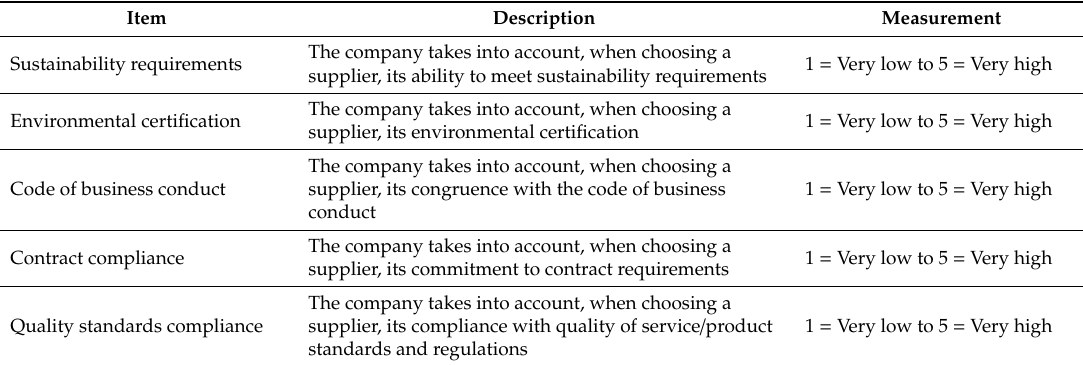
Table 1. Supplier Selection strategy